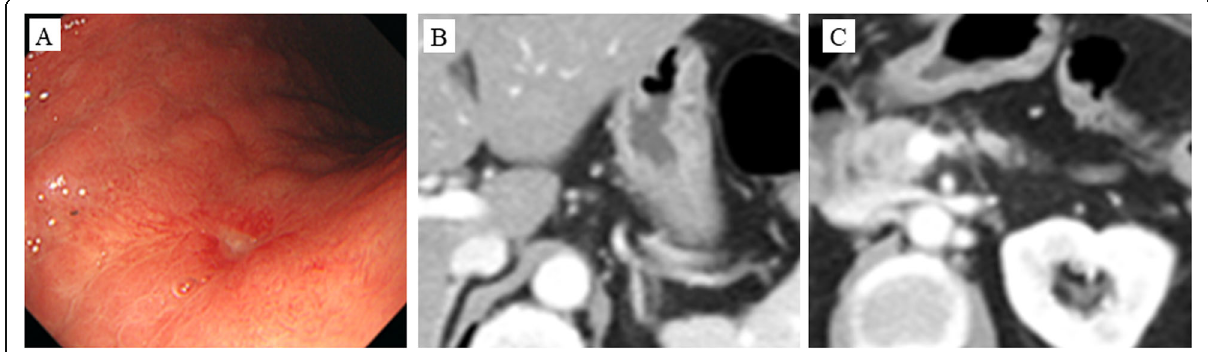
Fig. 3 Esophagogastroduodenoscopy (EGD) and computed tomography (CT) findings after chemotherapy. a EGD after chemotherapy detected a scar lesion instead of a tumor. Abdominal CT after the five courses of S-1, oxaliplatin, and trastuzumab revealed regression of the regional lymph nodes ( b ) and para-aortic lymph nodes ( c